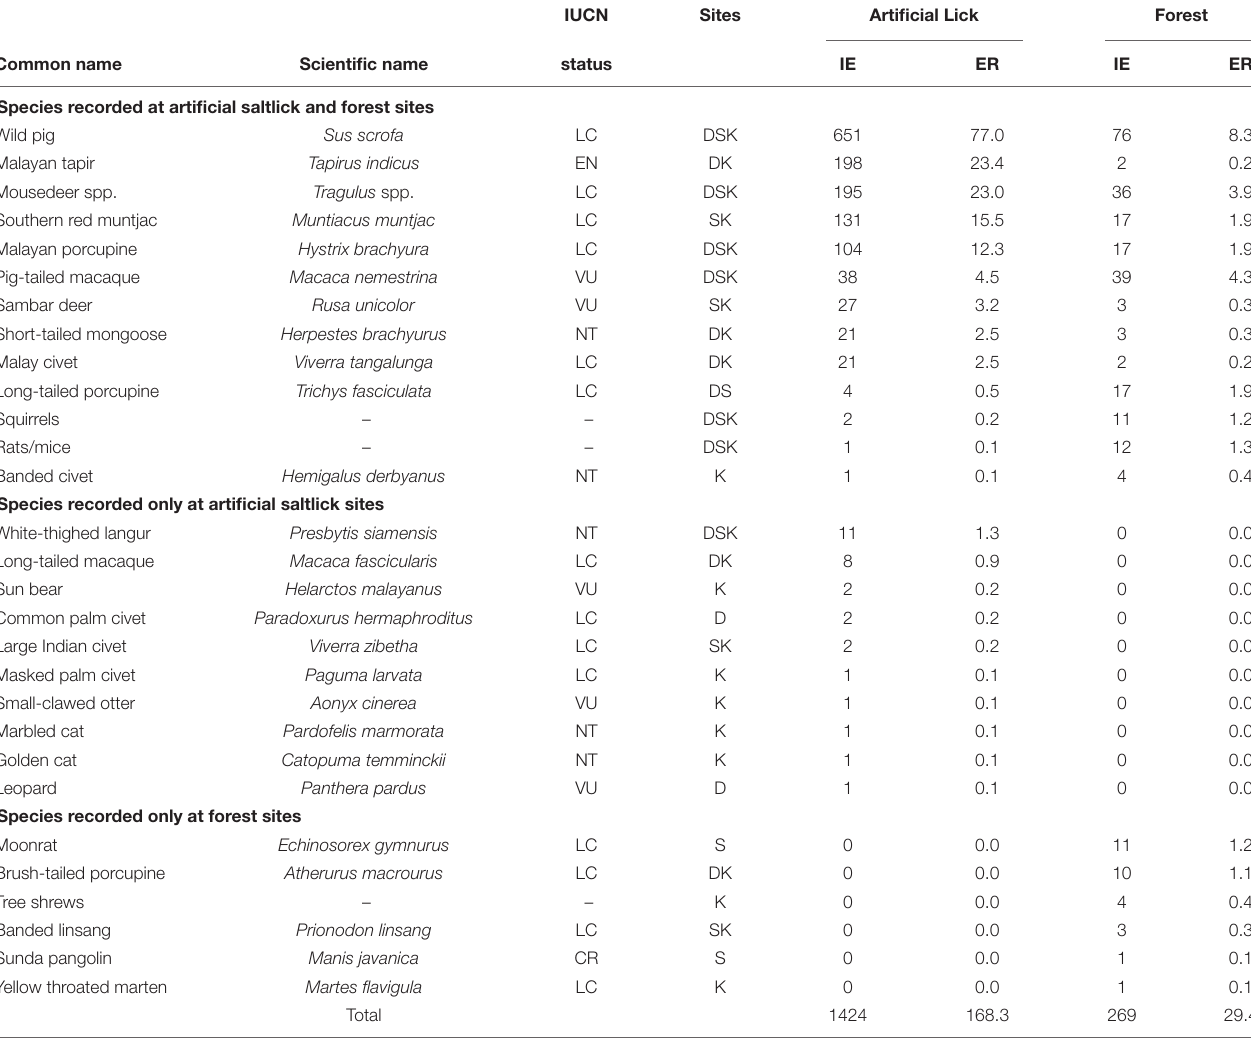
TABLE 1 | Mammal species (or groups) detected visiting artificial saltlicks and forest sites with camera traps. IUCN Sites Artificial Lick